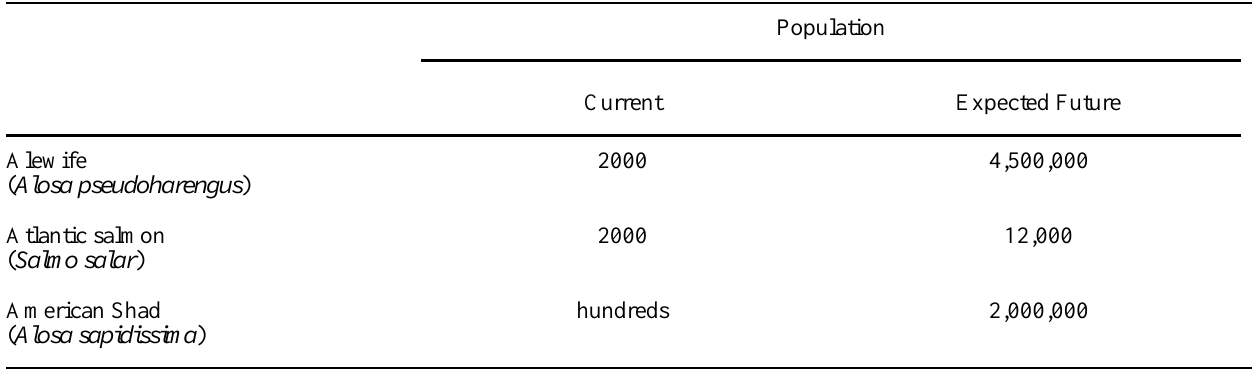
Table 3. Expected changes in fish populations in the Penobscot River from the Project by